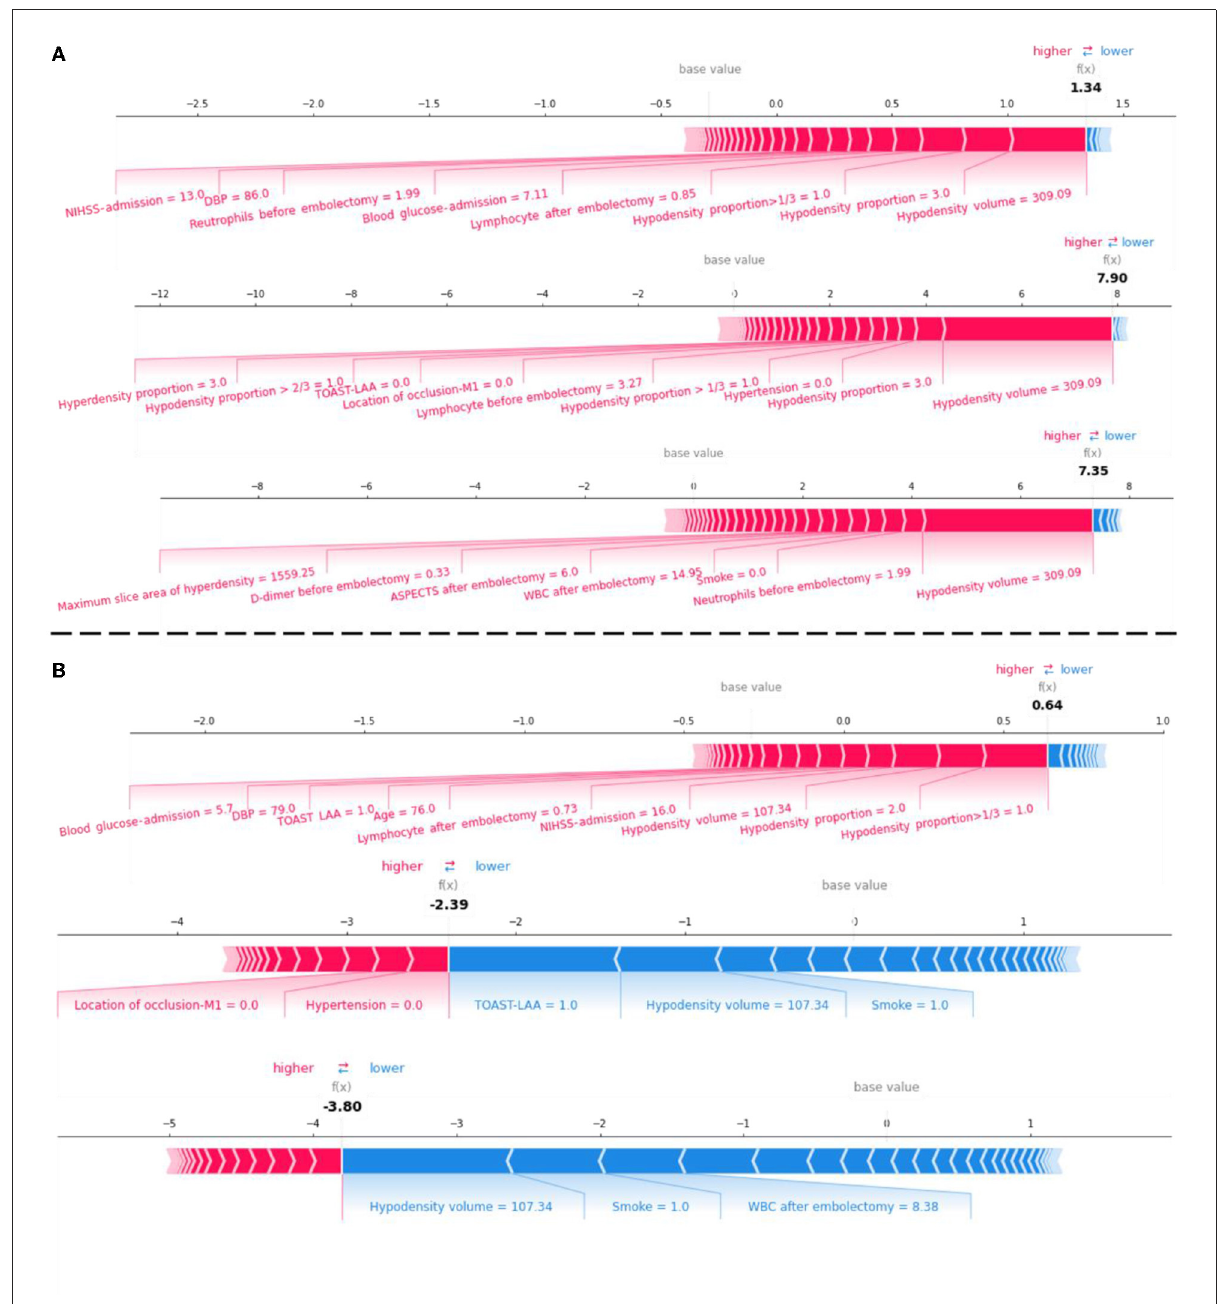
FIGURE6 The force plot for the LR-Stacking model decision process for evaluating the risk of futile recanalization, MCE, and CH in two patients with AIS in the test set. (A) A patient with mRS-90 of 5, indicating futile recanalization and developed MCE and CH. (B) A patient with mRS-90 of 2, indicating meaningful recanalization and did not develop MCE or CH. Each feature provides a SHAP value for the base value of the model. The final prediction value, f(x), is obtained using to the weight of the features and the model processing. When f(x) > 0, the model determines that the case is positive; otherwise, it is considered